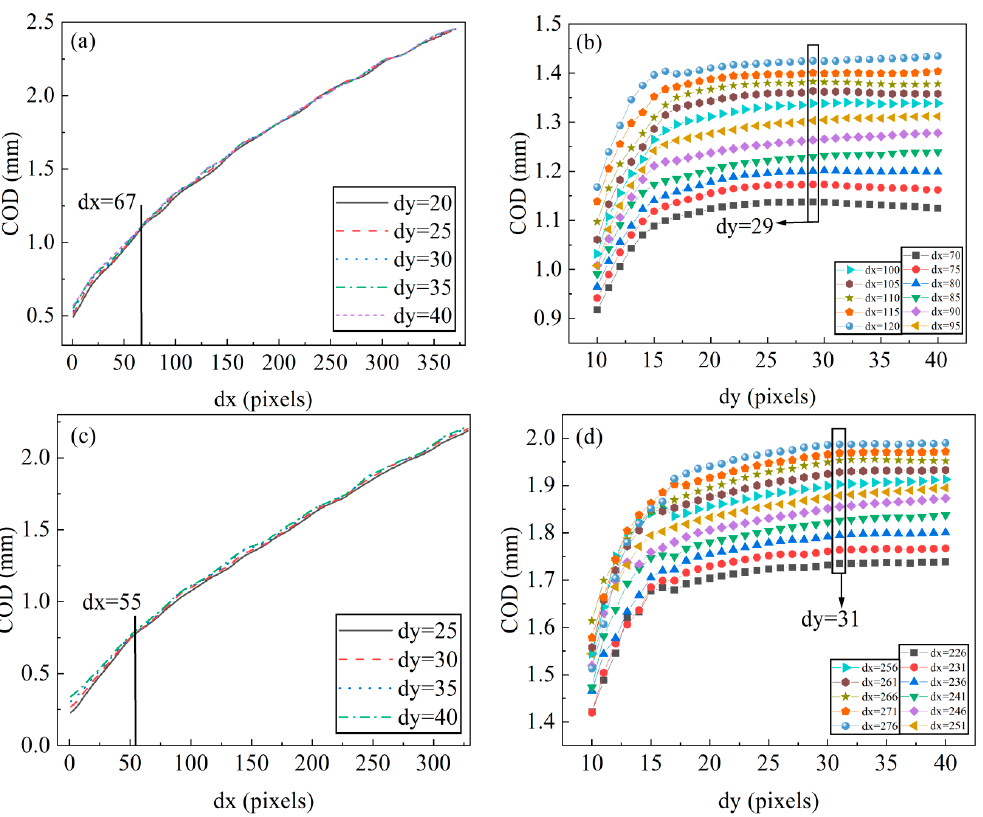
Figure 10. Determination of crack-tip opening displacement d x and d y : ( a ) determination for specimen B1, a = 25.02 mm d x ; ( b ) determination for specimen B1, a = 25.02 mm d y ; ( c ) determination for specimen, W1 a = 24.48 mm d x , ( d ) determination for specimen W1 a = 24.48 mm d y .